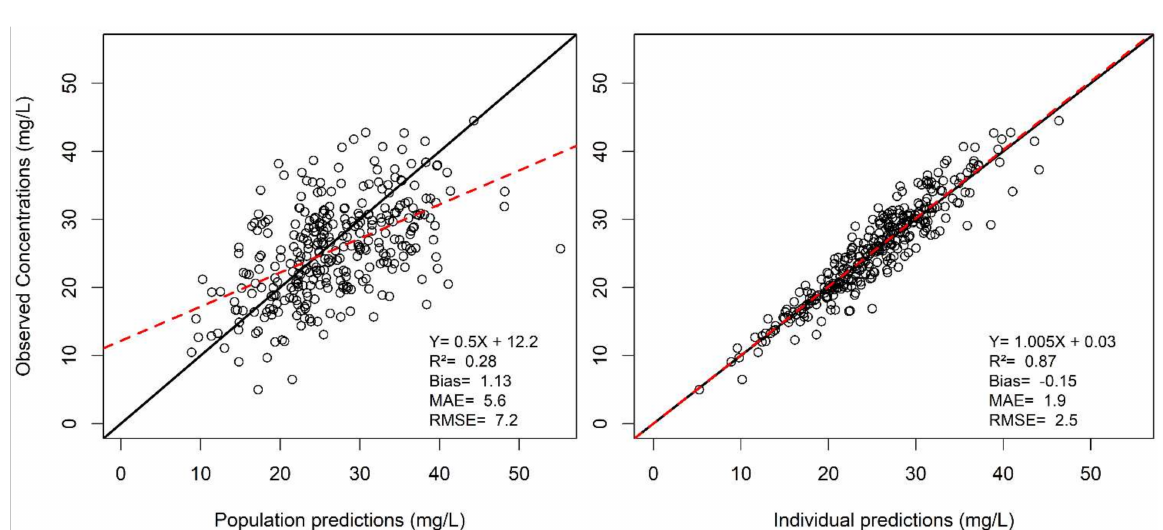
Figure 1. Observed versus predicted vancomycin concentrations in the learning